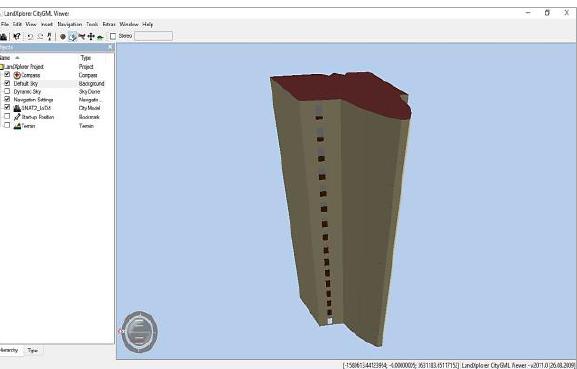
Figure 10. LoD4 CityGML building model of test